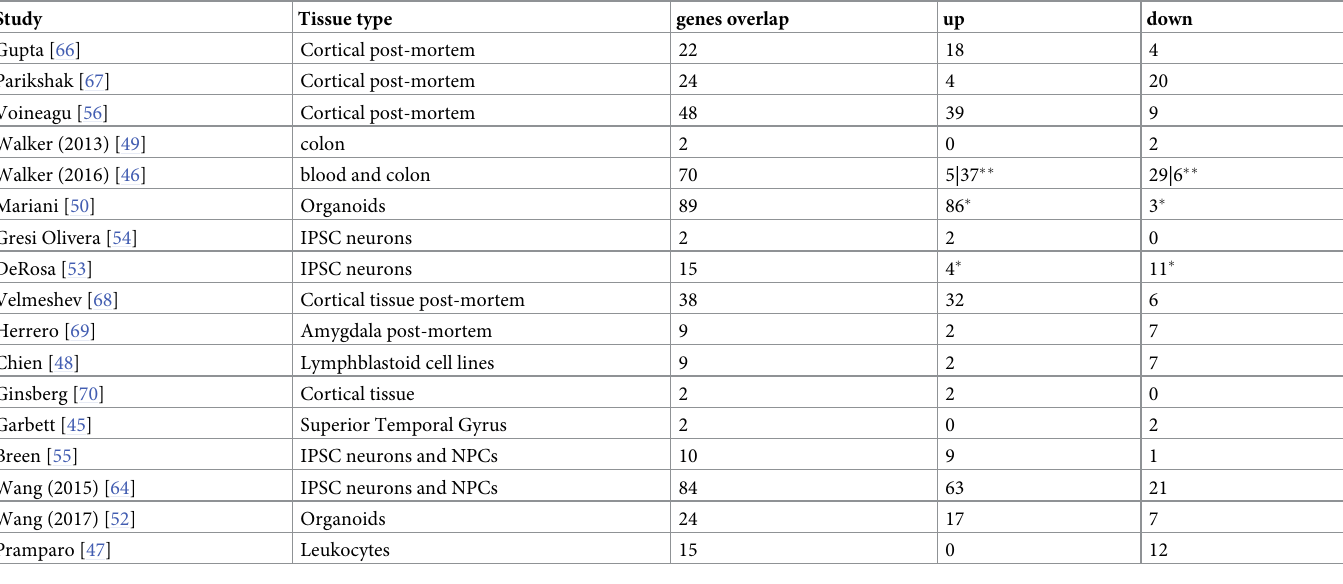
Table 4. Genes dysregulated in ASD expression studies that overlapped with our